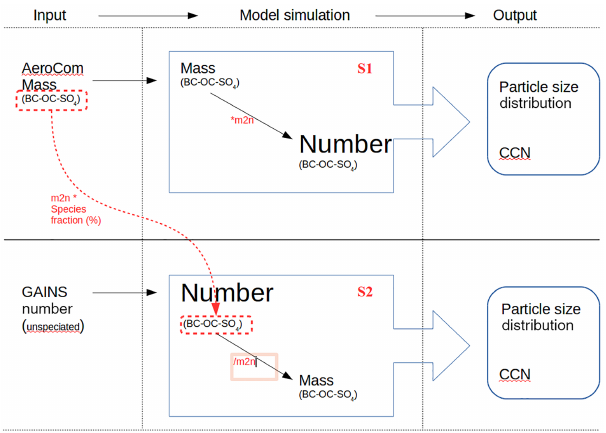
Figure 1. Framework describing the off-line steps to implement GAINS mass and number anthropogenic emissions in the ECHAM- HAM. The AeroCom mass-to-number (m2n) conversion factors and the chemical species fractions (%) of AeroCom number emissions were used to speciate GAINS number emissions. A specific m2n factor was used for each species for either mass-to-number (*m2n) or number-to-mass (/m2n)